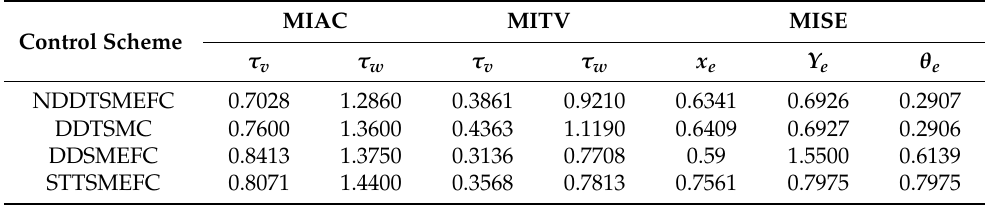
Table 1. UROV quantitative analysis